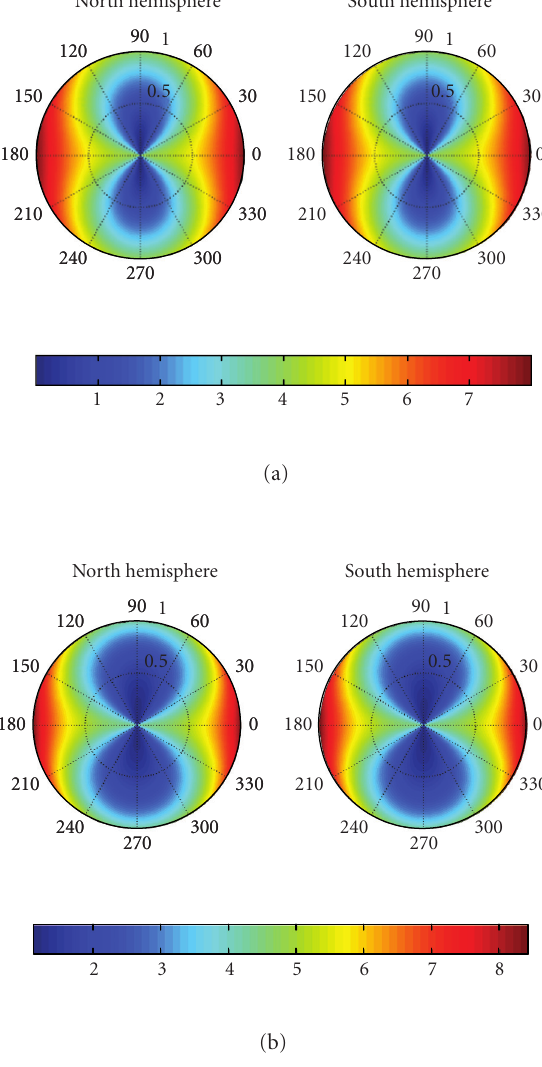
Figure 6.4. (a) Spherical plot of the initial function F t which provides the data vector V . (b) Solution obtained by Algorithm 5.5 corresponding to the data V of the function F t